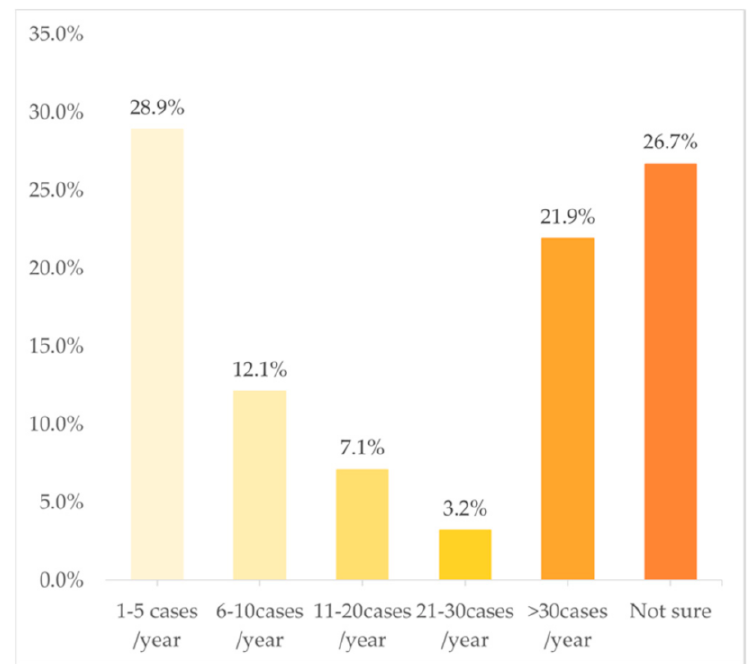
Figure 3. Frequency of work involved in PGx tests ( n = 588).